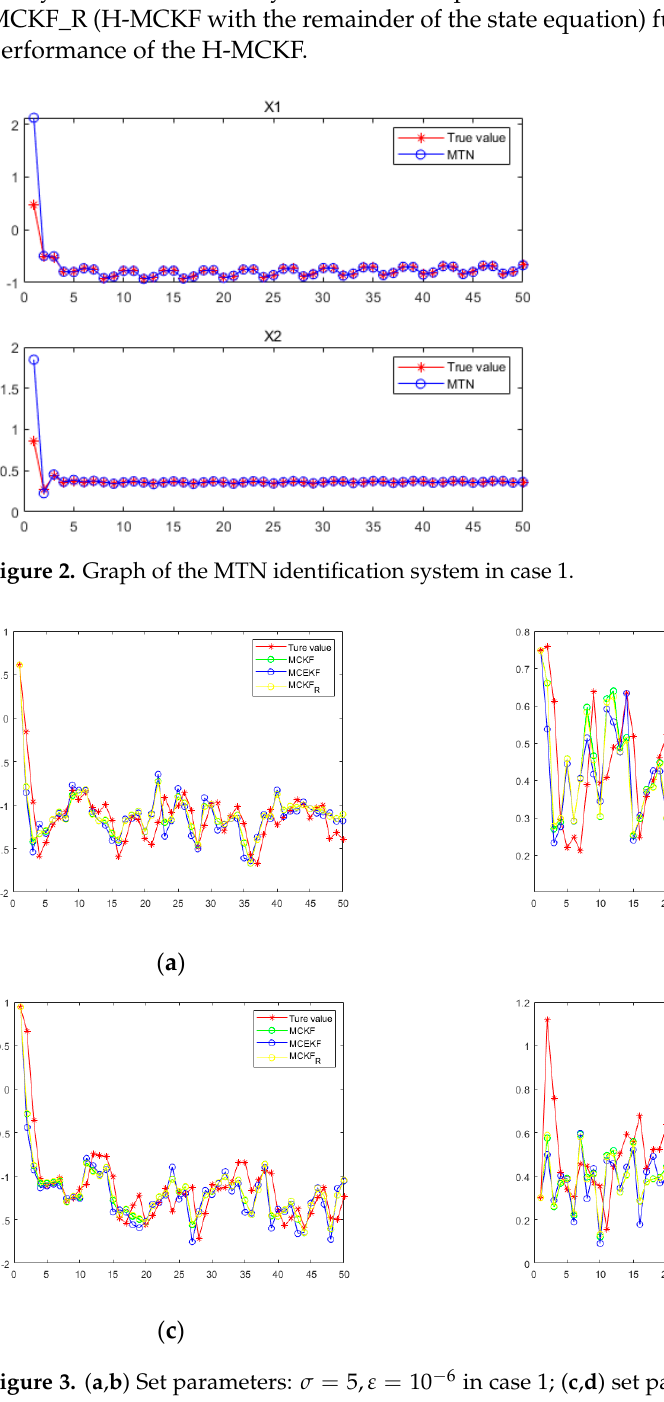
Table 2. The mean relative error using the three methods in case 1.